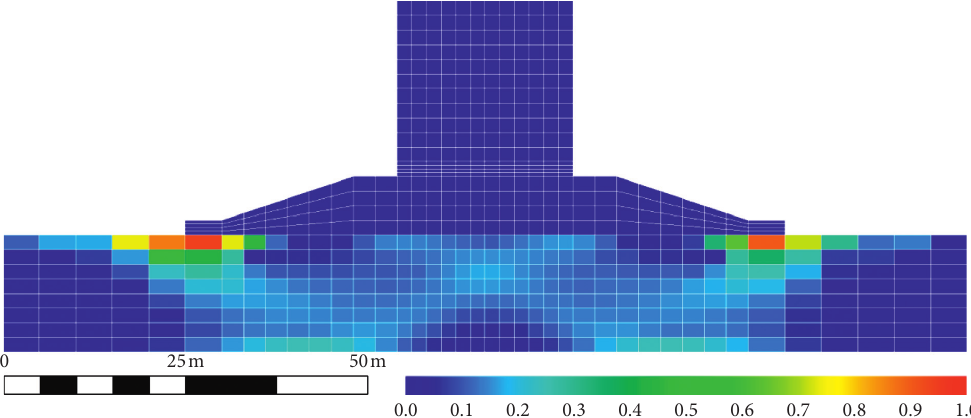
Figure 16: Final distribution state of excess pore water pressure ratio.